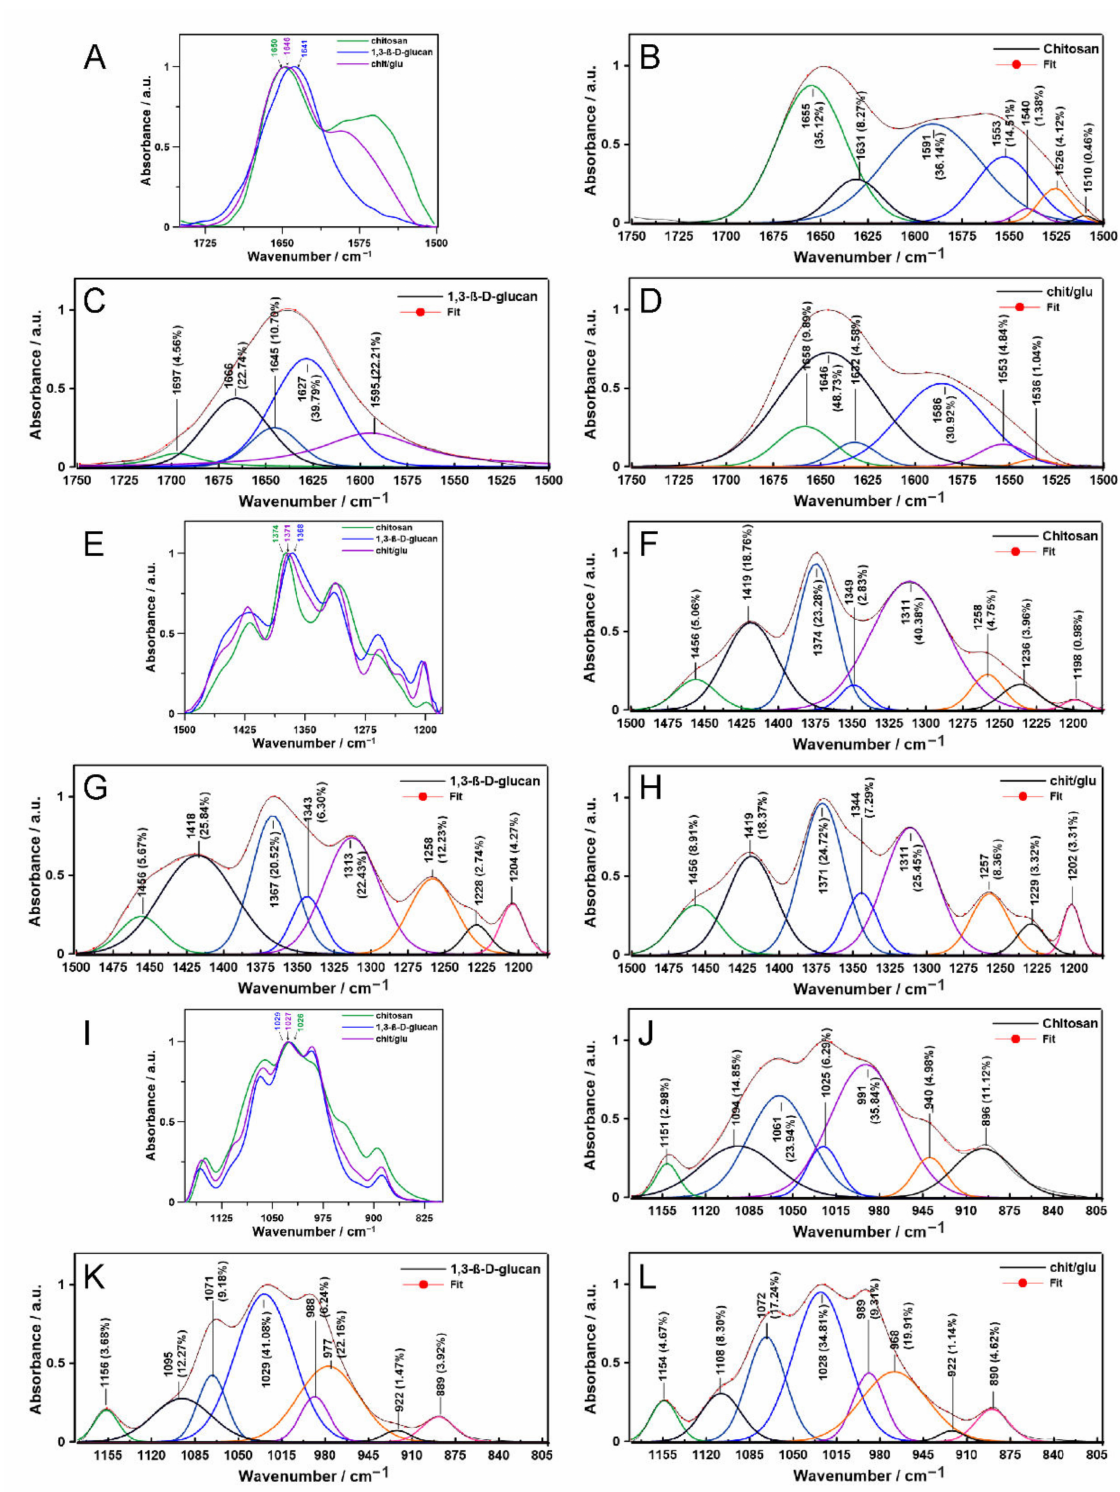
Figure 2. The normalized ATR FT-IR absorbance ( A , E , I ) spectra in the selected ranges and band deconvolution with the application of mixed Lorentzian/Gaussian curve fitting ( B – D ): 1750–1500 cm − 1 , ( E – H ): 1500–1180 cm − 1 : ( J – L ): 1180–800 cm − 1 . Each subband has marked a maximum value and a percentage share of the whole band surface